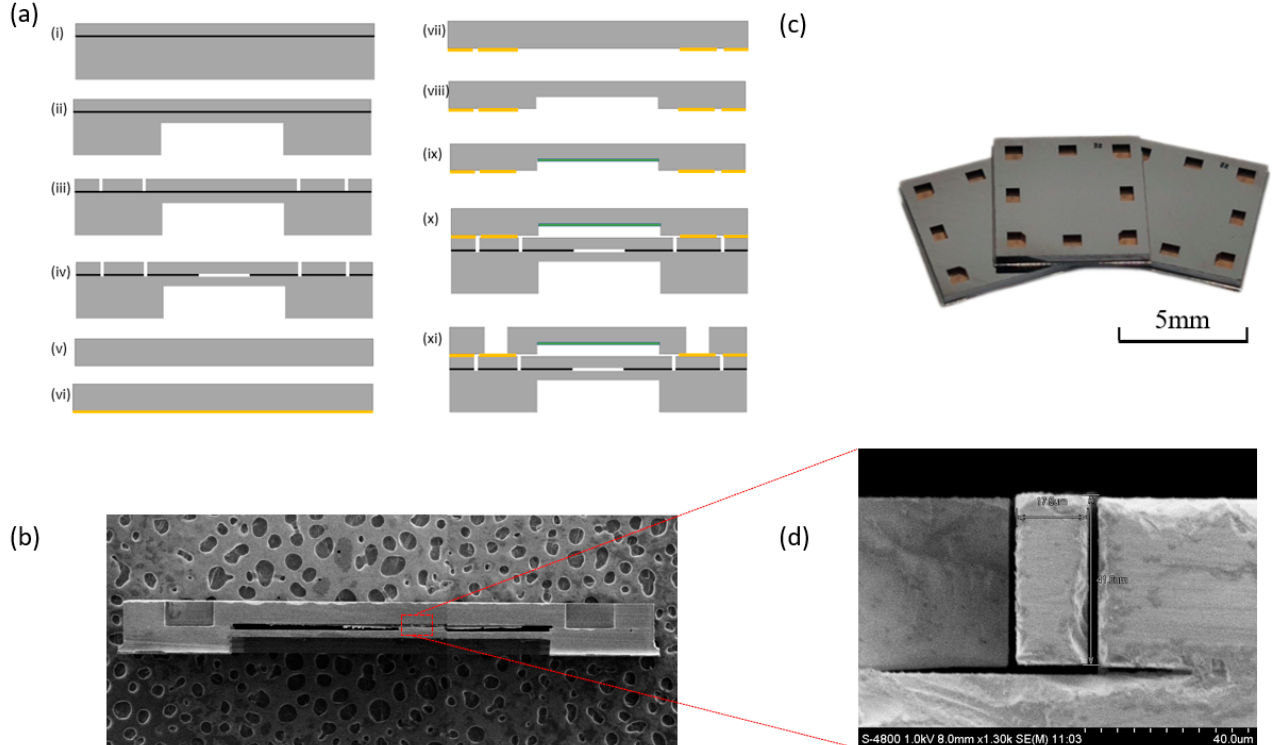
Figure 3. ( a ) Schematic of the fabrication flow chart: (i) cleaning SOI, (ii) etching pressure-sensitive film, (iii) etching device layer to form resonators, (iv) releasing resonators, (v) cleaning silicon wafer, (vi) evaporating Cr/Au, (vii) patterning Cr/Au, (viii) etching vacuum cavity, (ix) evaporating getter, (x) eutectic bonding, and (xi) etching electrodes. ( b ) SEM image of the cross section of the chip. ( c ) Images of fabricated sensor chips. ( d ) A cross-sectional SEM image of the resonator.